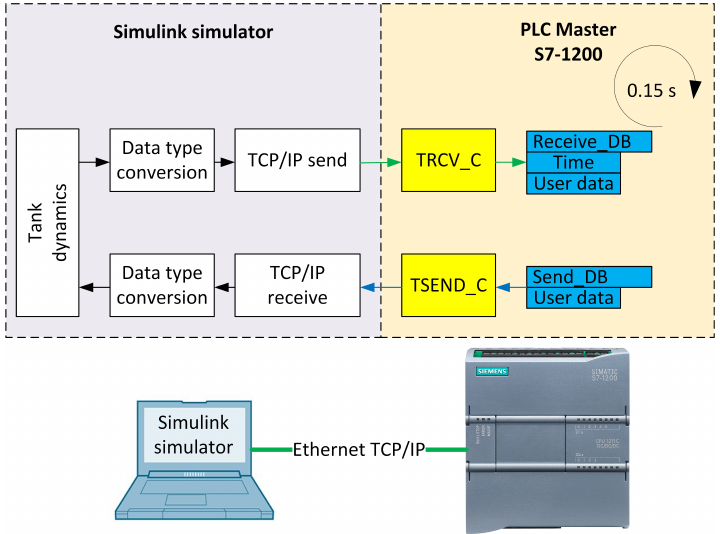
Figure 2. Communication between the PLC and Simulink